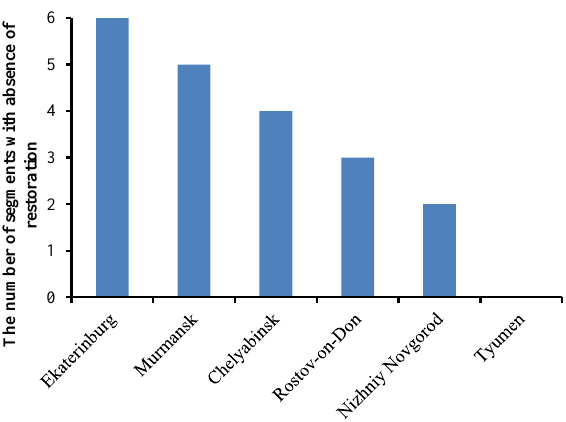
Figure 9. The number of segments with delayed restoration after earthworks and construction.